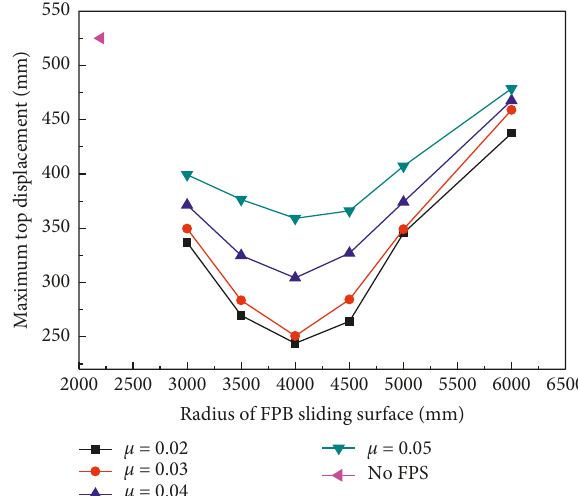
Figure 16: The maximum top displacement of T2 tower with R and μ in the Y direction under L0689S wave.